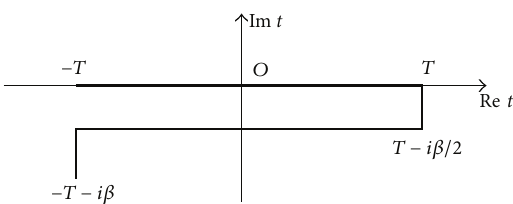
Figure 1: The contour 𝐶 in the complex time plane used here for the real-time